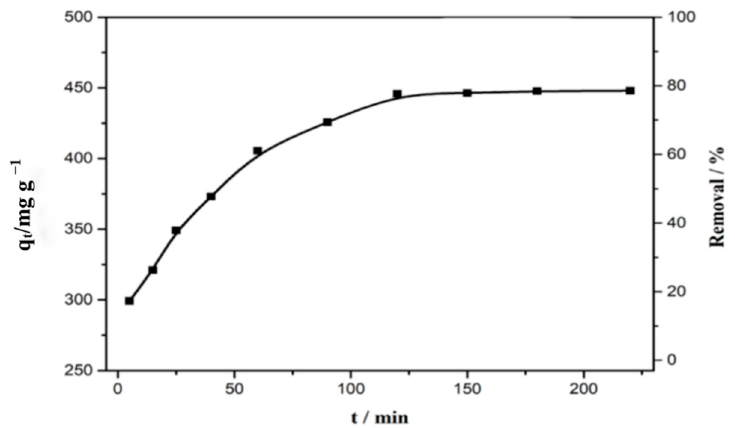
Figure 9. Relationship between methylene blue adsorption time and adsorption amount.